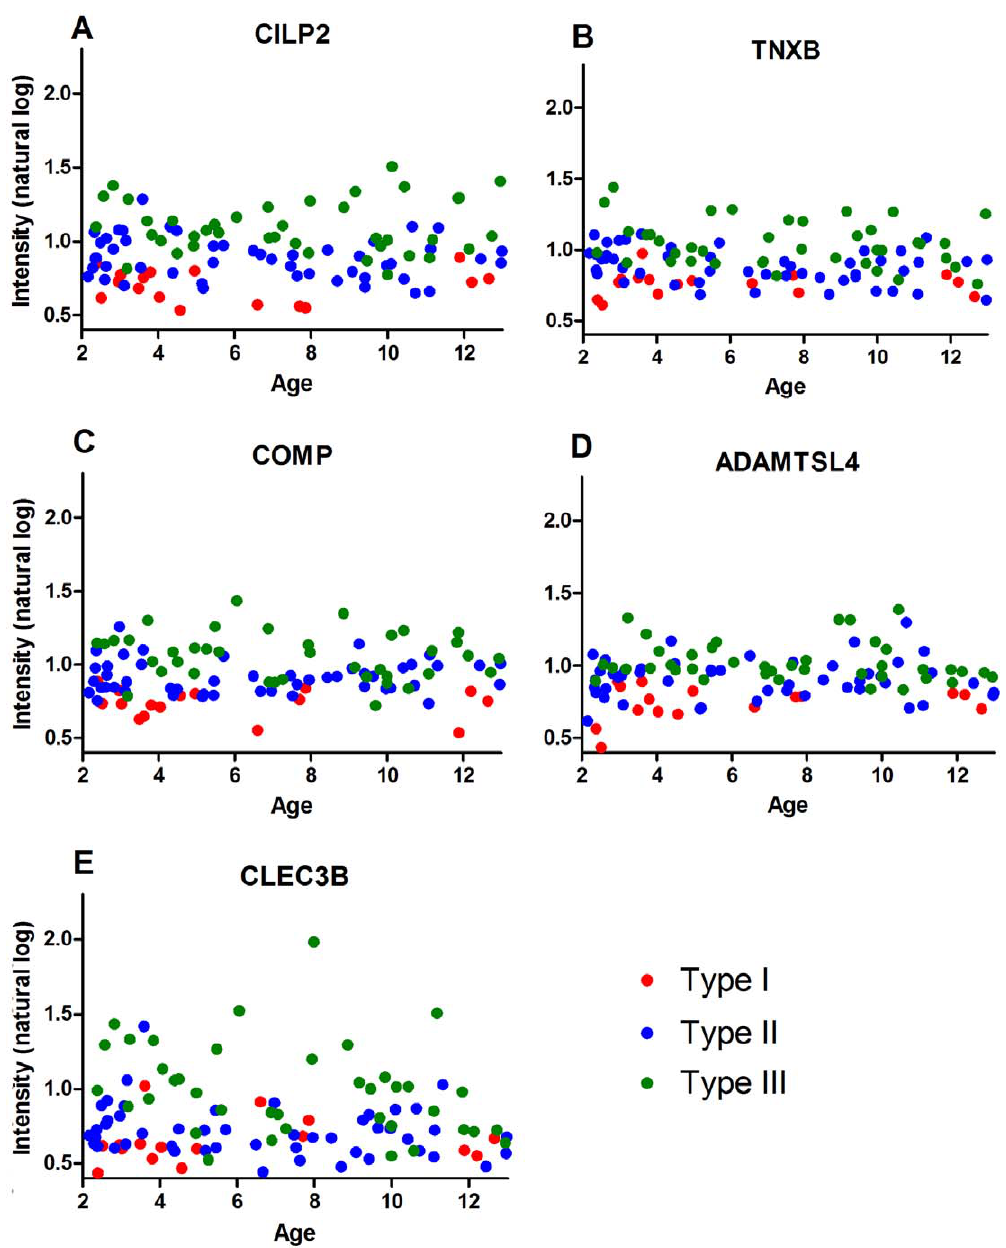
Figure 1. Illustration of the top 5 markers as candidate biomarkers by age. The natural log intensity of the protein abundance of CILP2, TNXB, COMP, ADAMTSL4 and CLEC3B are shown by age (Panels A-E) across Types. Panels A-E generally show a trend for type but not age.